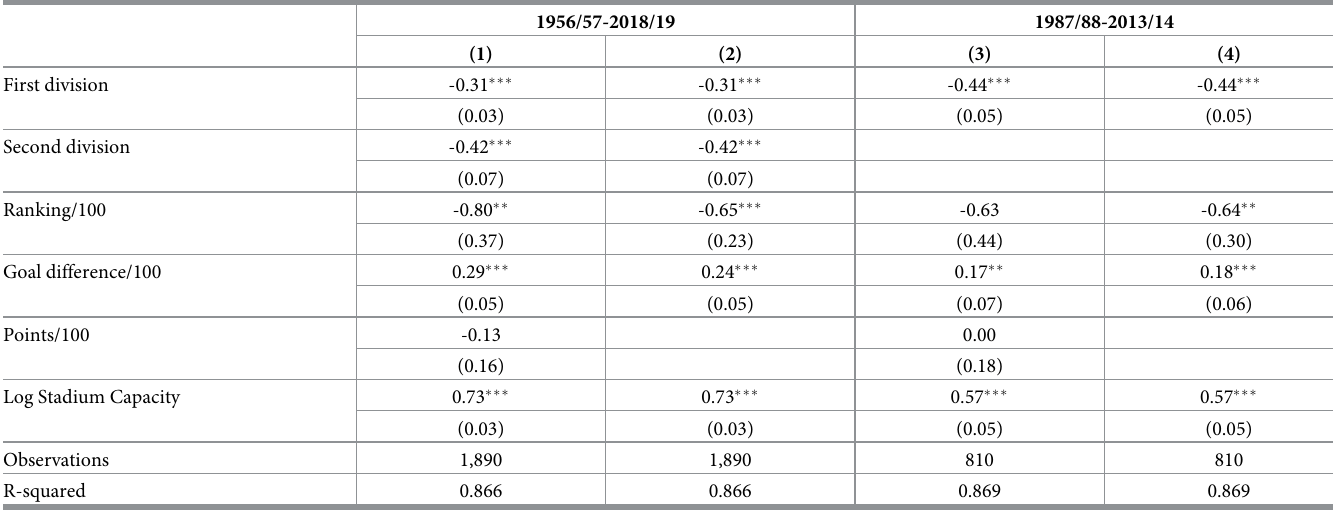
Table 4. Parameter estimates stadium attendance; first stage—club-specific